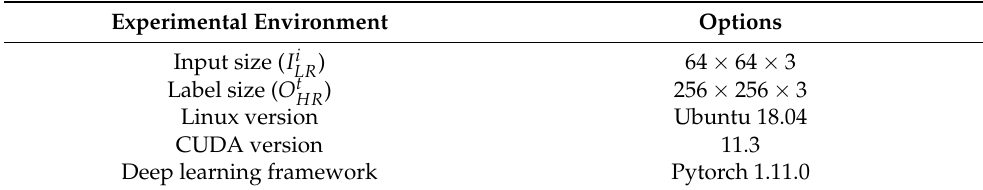
Table 6. Experimental environment.